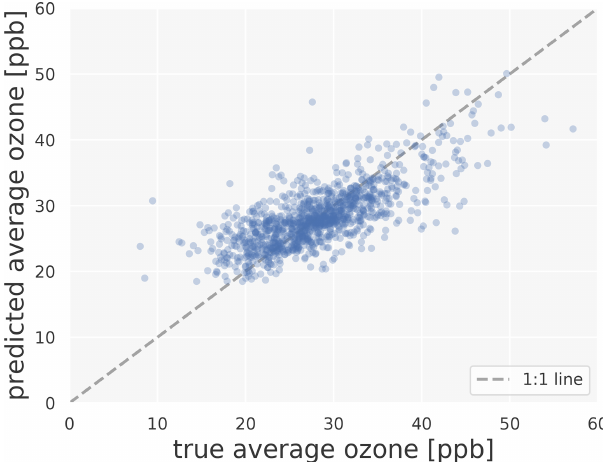
Figure 2. Predicted ozone values versus measurement values of the test set of the AQ-Bench dataset. See Sect. 3.3.1 for the specifica- tions of the used machine learning